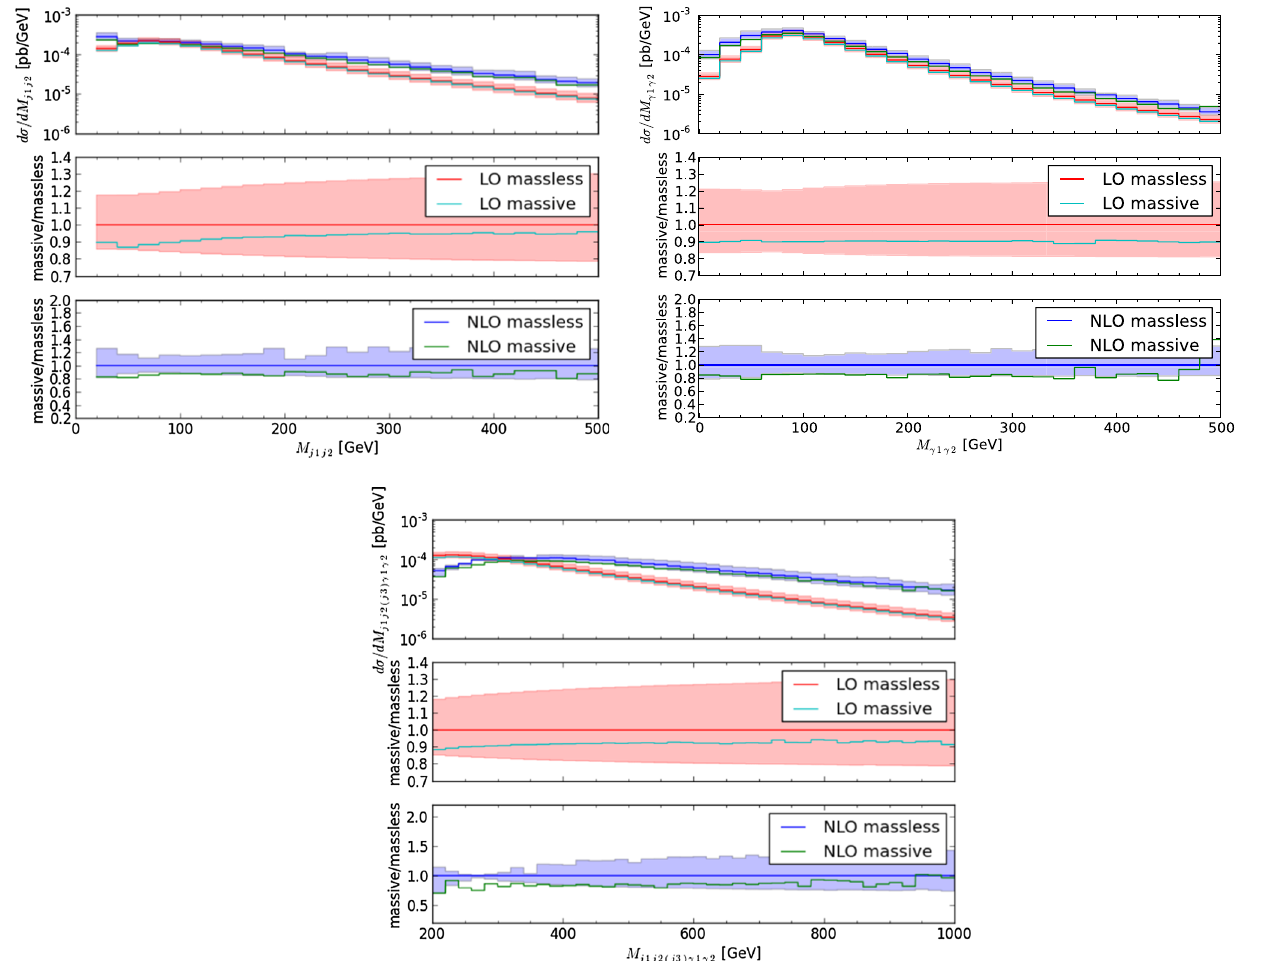
Fig. 10 Invariant mass distribution for the two leading jets and the two photons (upper row) and for the total invariant mass (lower row) for massive b -quarks